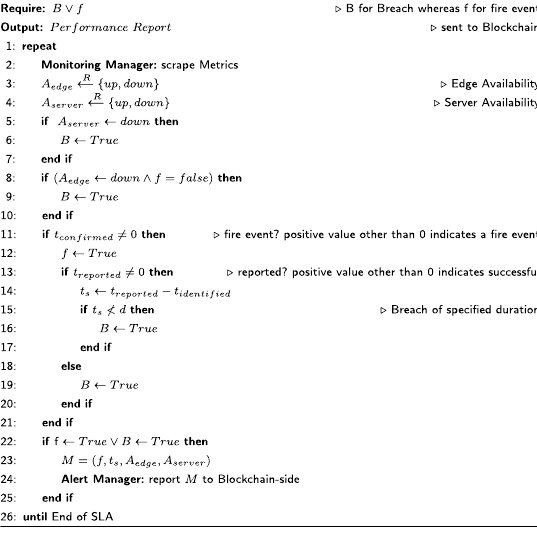
Validating the monitoring